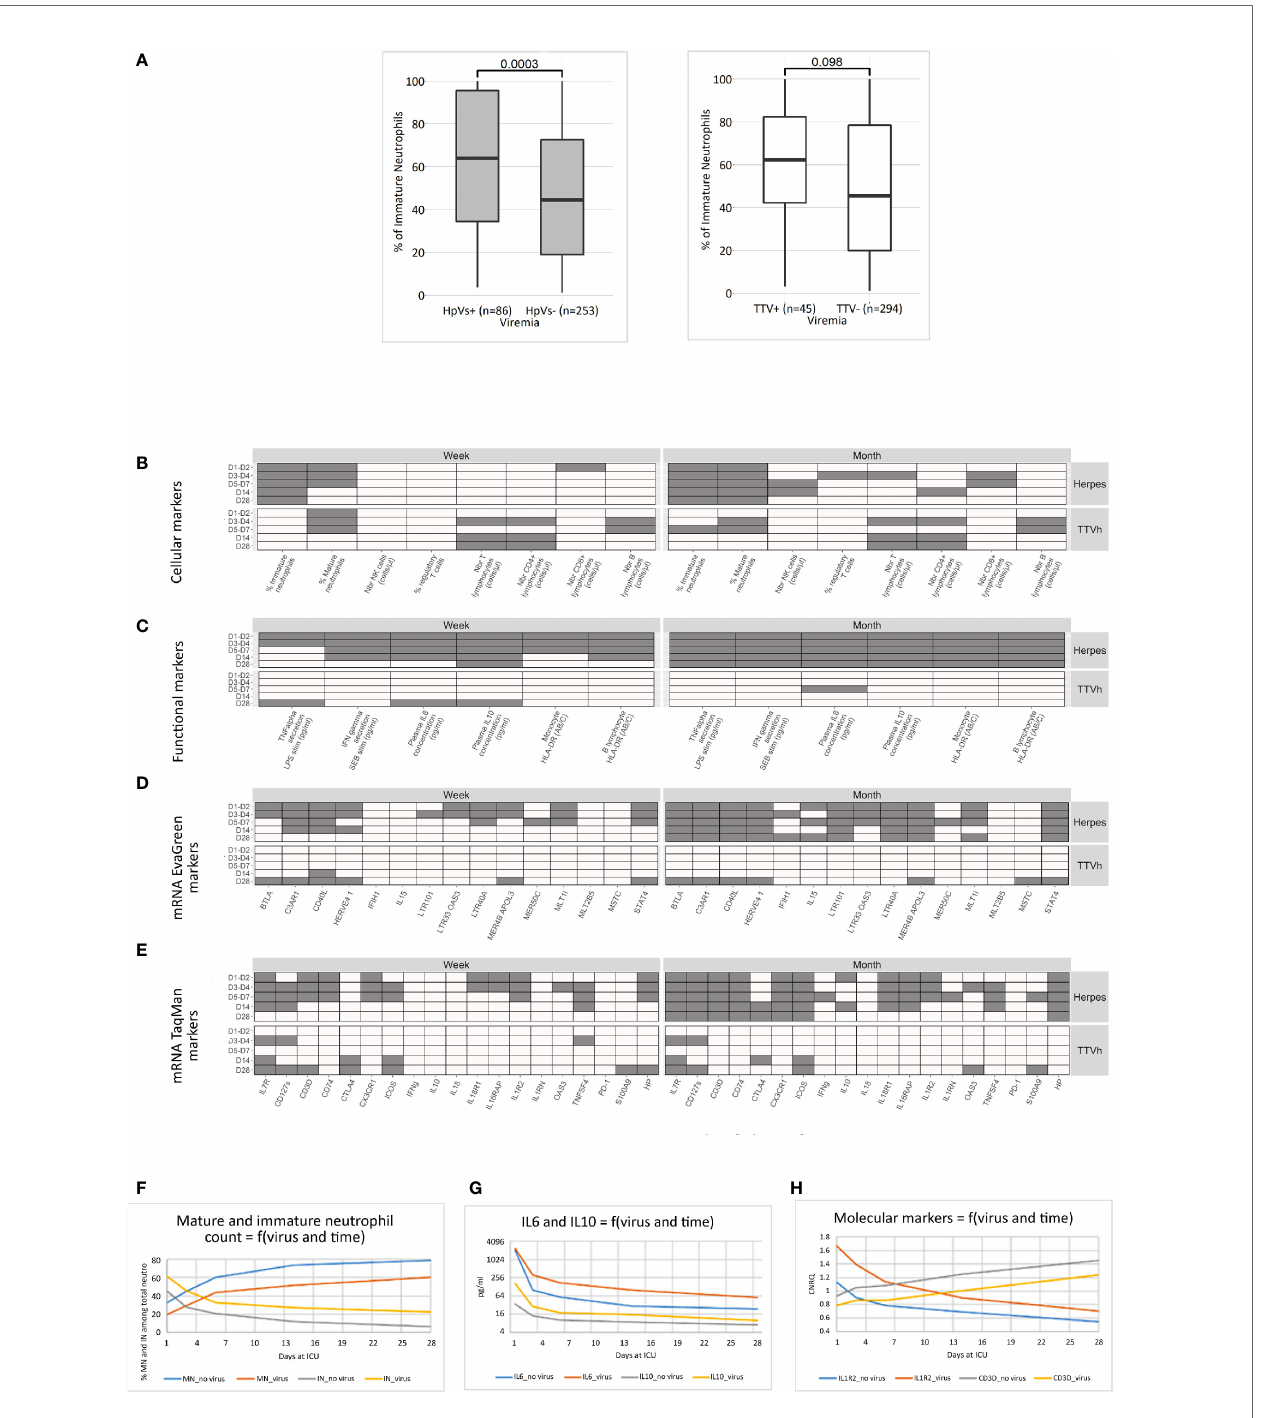
FIGURE 2 | Association of viraemia with immunological and molecular markers. Wilcoxontests amongglobal pathological conditionswere performedto compare markers distribution atdifferent time points (D1 – D2, D3 – D4, D5 – D7, D14, andD28) and viraemia (allHerpes or TTVh) detection statusduringthe fi rst week (D1 – D7) and the fi rst month (D1 – D28). (A) Illustration ofa signi fi cant (left) anda non-signi fi cant (right) association between viraemia during the fi rst week(herpesviruses, left; TTVh, right) and immature neutrophil percentages at D1 – D2. Signi fi cant associationsare represented respectivelyby a grey box and non-signi fi cant associationsby a white box in the following fourcharts (B – E) . Signi fi cant associationsbetween viraemia and (B) cellular marker ( fl ow cytometry), (C) functional markers (immune functional assay, plasma cytokine concentrations, cell-surface HLA-DR), (D) mRNA transcripts detected byRT-PCR_EVaGreen, and (E) mRNA markers detected by TaqMan RT-PCR are indicated as grey boxes. Comparative kinetics ofsix identi fi ed markers(mean expression inthe wholecohort) was depicted as a function oftimeand the presence of herpes viremia in the D1-D28 period for (F) mature (CD10high_CD16high)and immature (CD10low_CD16low)neutrophils, (G) serum Il6and IL10, and (H) IL1R2 an CD3D molecular